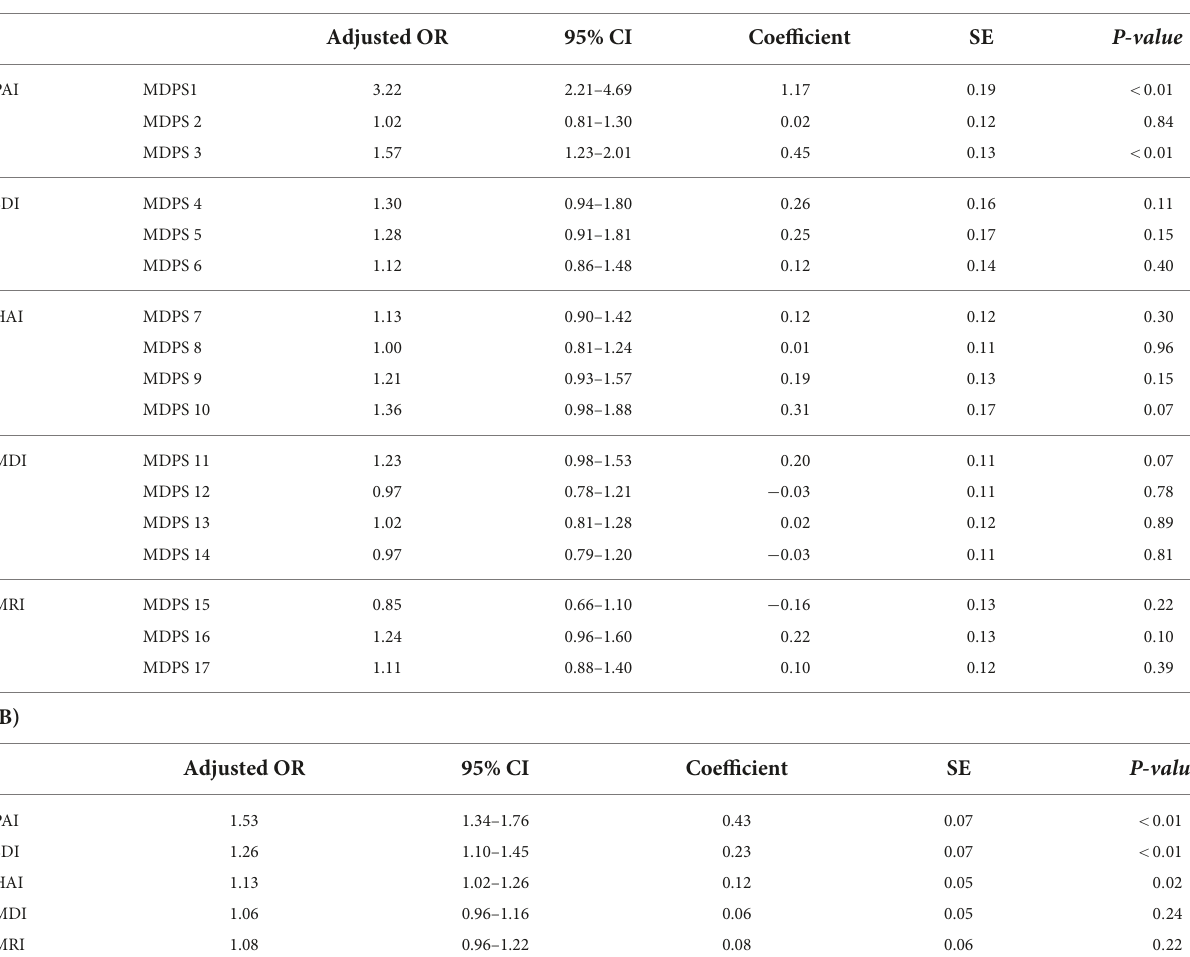
TABLE 3 Results of the multivariable regression analysis of the